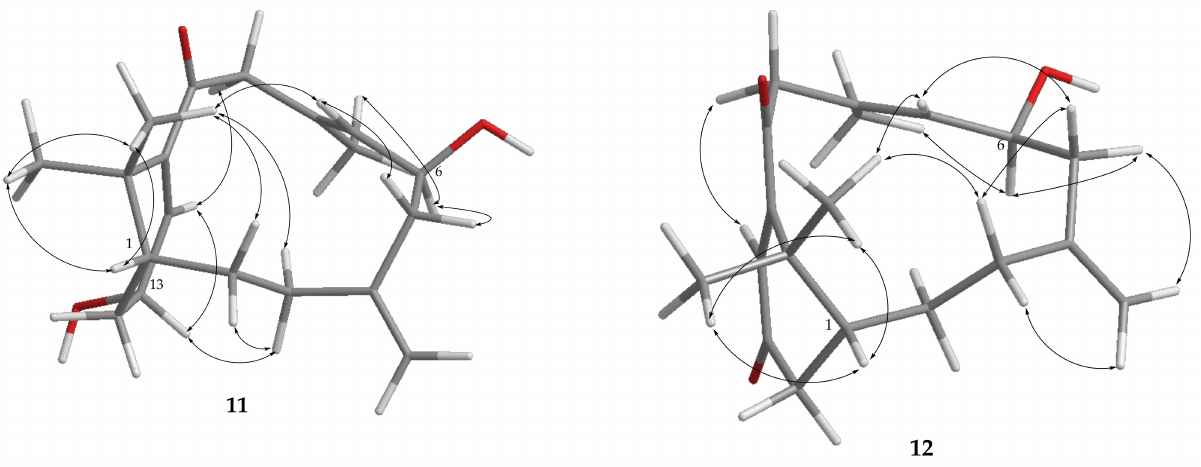
Figure 10. Selected NOE correlations of compounds 11 and 12